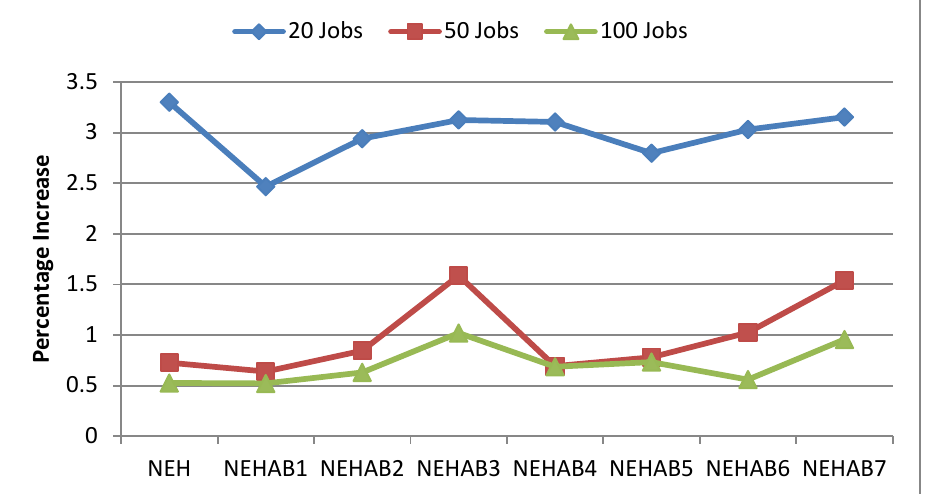
Fig. 1. Percent Increase Plot for 5 Machines